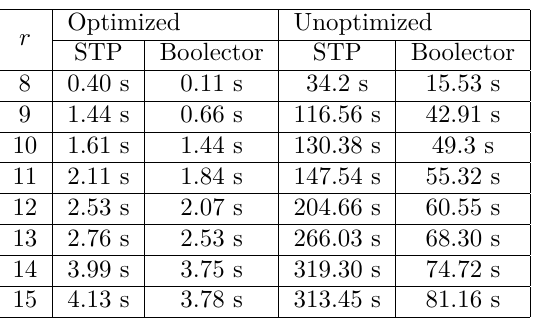
Table 9: The impact of the CRAFT ’s S-box optimization on the solvers’ run-time, to find an optimum differential trail with fixed input, and output differences for r rounds of CRAFT Optimized r